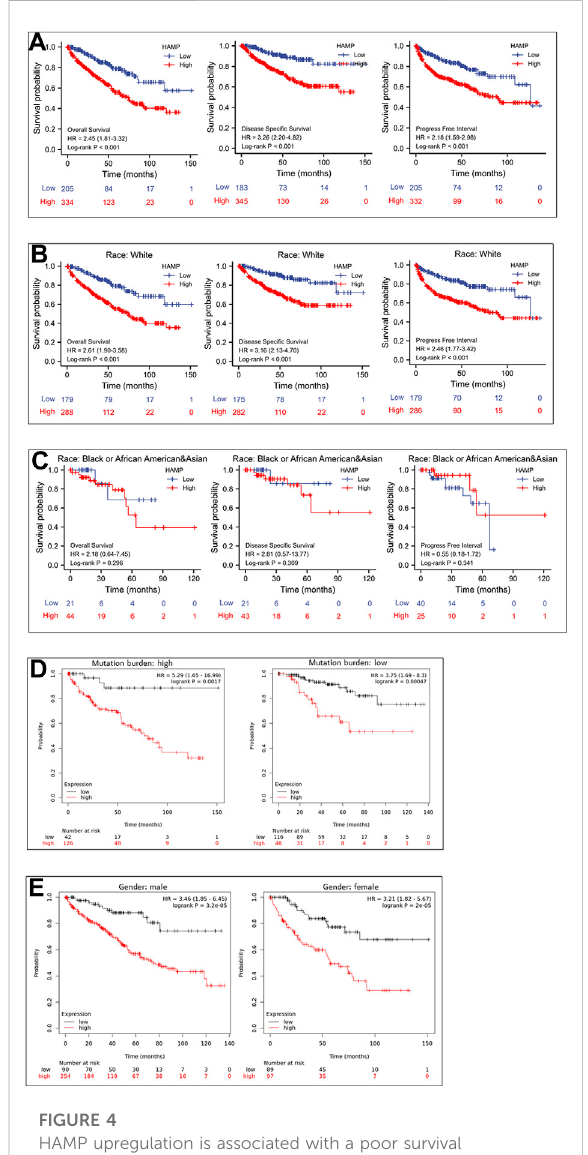
FIGURE 4 HAMP upregulation is associated with a poor survival outcome in ccRCC patients. (A) Patient survival outcomes of overall survival, disease-speci fi c survival, and progression-free intervals were analyzed based on HAMP expression levels using the minimum p -value approach, as described (Menyhart et al., 2018). The 95% con fi dence interval of the H.R. value was listed within the parentheses. (B – E) Overall survival outcomes were compared between different groups using the minimum p -value approach described (Menyhart et al., 2018).